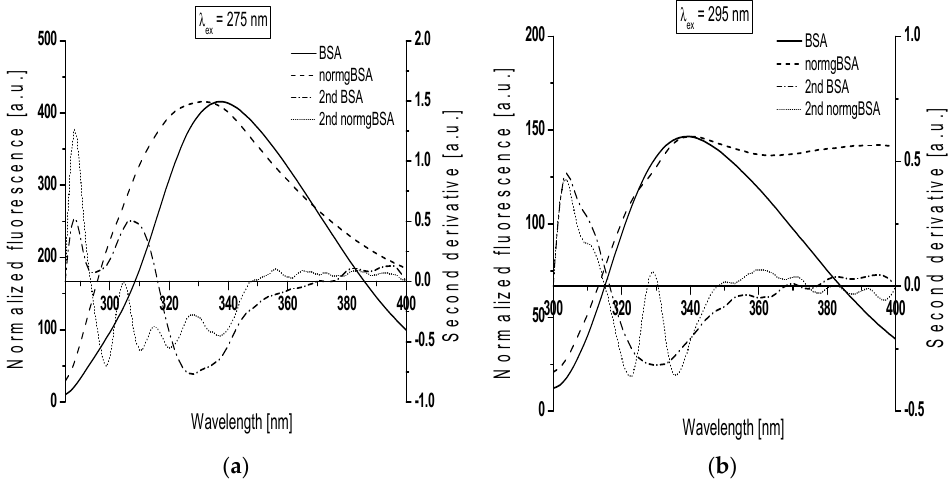
Figure 4. Glycated albumin emission spectrum normalized to non-glycated (normgBSA) and their second derivative fluorescence spectra (2nd BSA, 2nd normgBSA) for: ( a ) λ ex = 275 nm; and ( b ) λ ex = 295 nm. The spectra were normalized to their respective maxima around λ em = 340 nm, T = 309